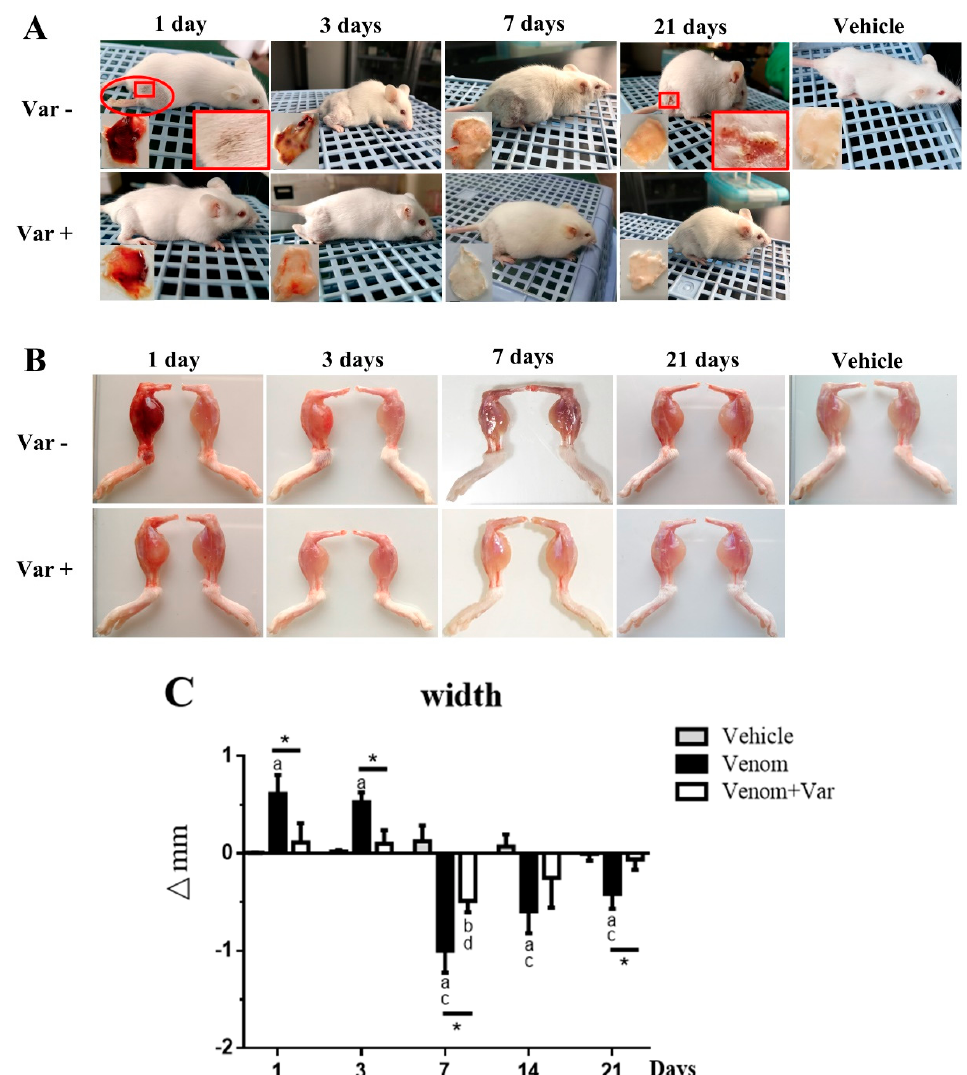
Figure 1. Macroscopic observation of overall signs and gastrocnemius muscle edema during the rehabilitation process. ( A ) The envenomed status of mice inoculated with D. acutus venom i.m. was tightly related with varespladib. Severe subcutaneous hemorrhage, paralytic hind leg, and skin ulceration developed in the venom group (day 1). Muscle contraction recovery, hemorrhage clearance, skin scabs and heals appeared serially during the rehabilitation process; ( B ) Morphological changes in gastrocnemius muscle. The envenomed muscle exhibited hemorrhage and edema during the early stage, atrophy was observed in the regenerative period; ( C ) Variation in gastrocnemius muscle width. ∆ mm = width subtraction of the right limb to the left limb. Data were presented as means ± SD ( n = 3). * p Venom vs. Venom + Var ( p < 0.05), “a” p < 0.05 Venom vs. Vehicle, “b” p < 0.05 Venom + Var vs. Vehicle, “c” p < 0.05 Venom vs. Venom day 1, “d” p < 0.05 Venom + Var vs. Venom + Var day 1, Varespladib was abbreviated as Var.